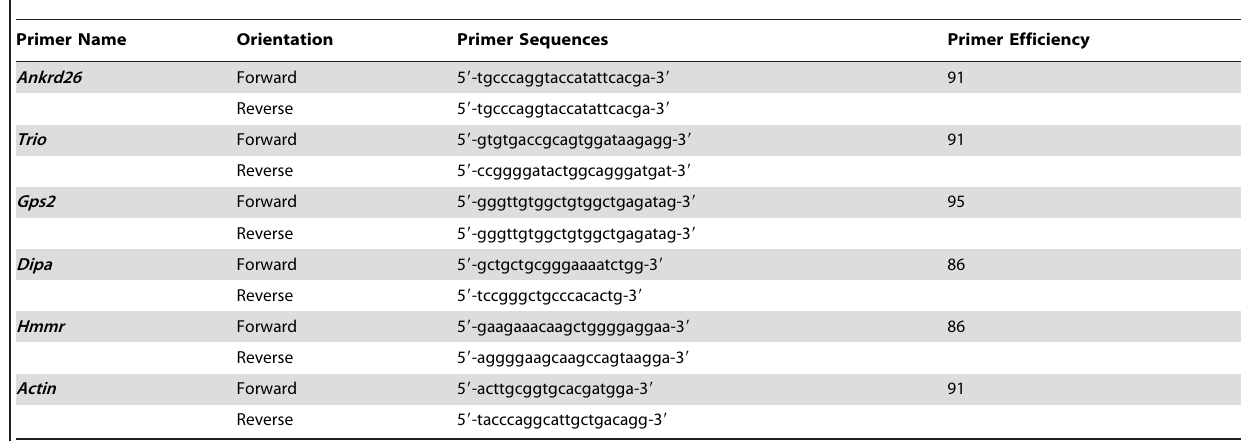
Table 2. Real Time Quantitative PCR primer sequences and primer efficiencies.